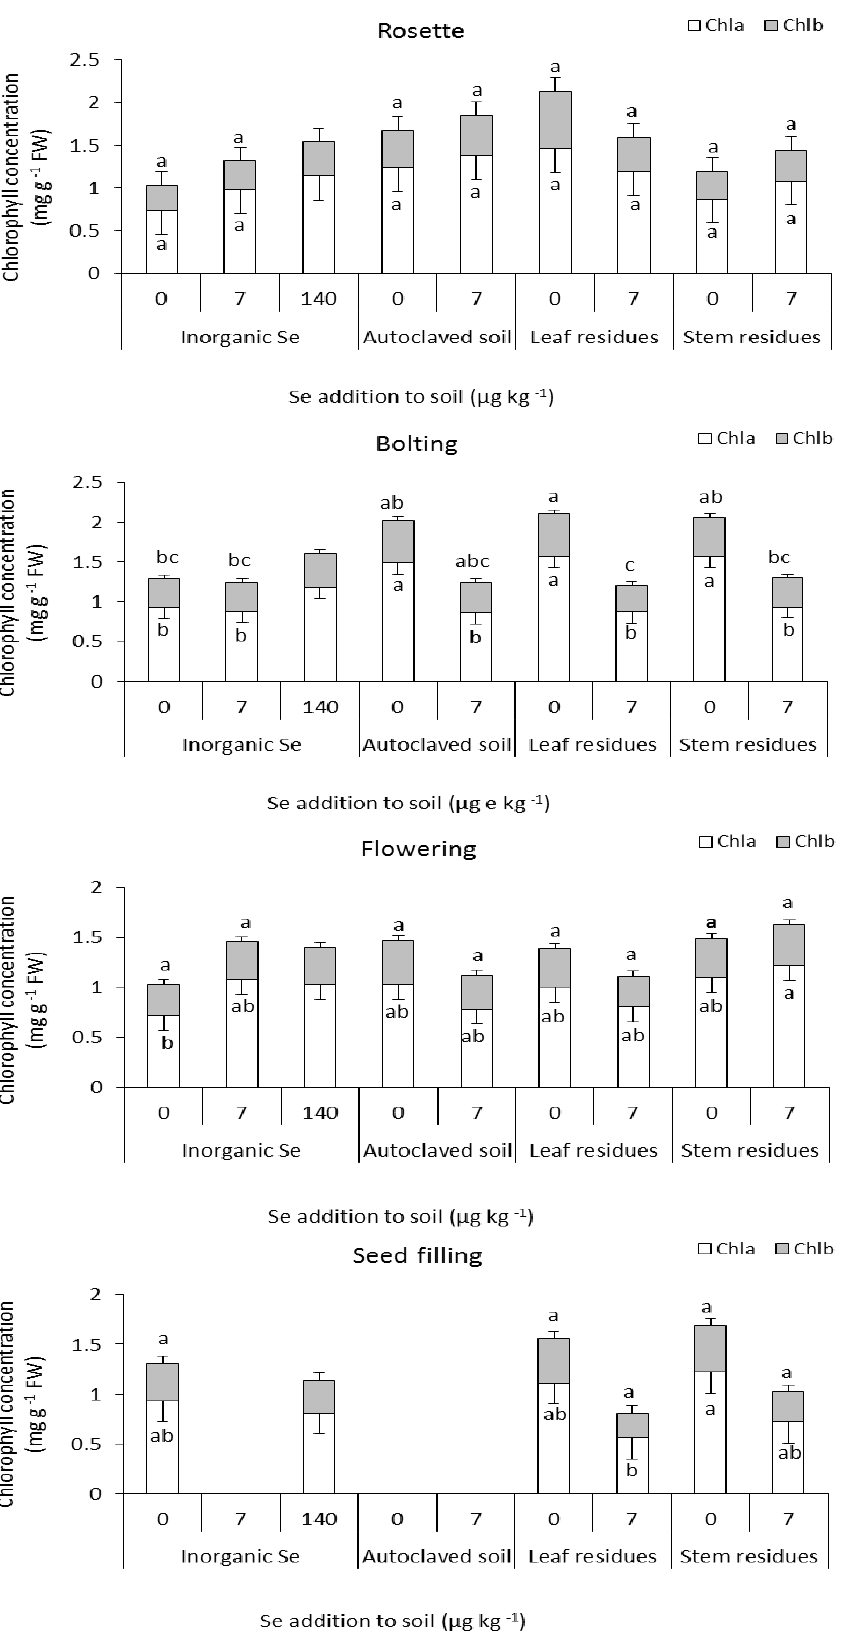
Fig. 2. Chlorophyll a and b (Chl a and b mg g -1 FW leaf) concentrations in leaves of B. napus L. plants that were grown in soil treated with inorganic Se (0, 7 and 140 µg kg -1 soil), organic Se (leaf and stem residue, 0 and 7 µg kg -1 soil) and in autoclaved soil with inorganic Se (0 and 7 µg kg -1 soil) at different growth development stages. Data are given in means ± SE, n=4. The same letter indicates no significant difference among bars with same colour, at p ≤ 0.05. The highest level of Se addition was not included in statistical